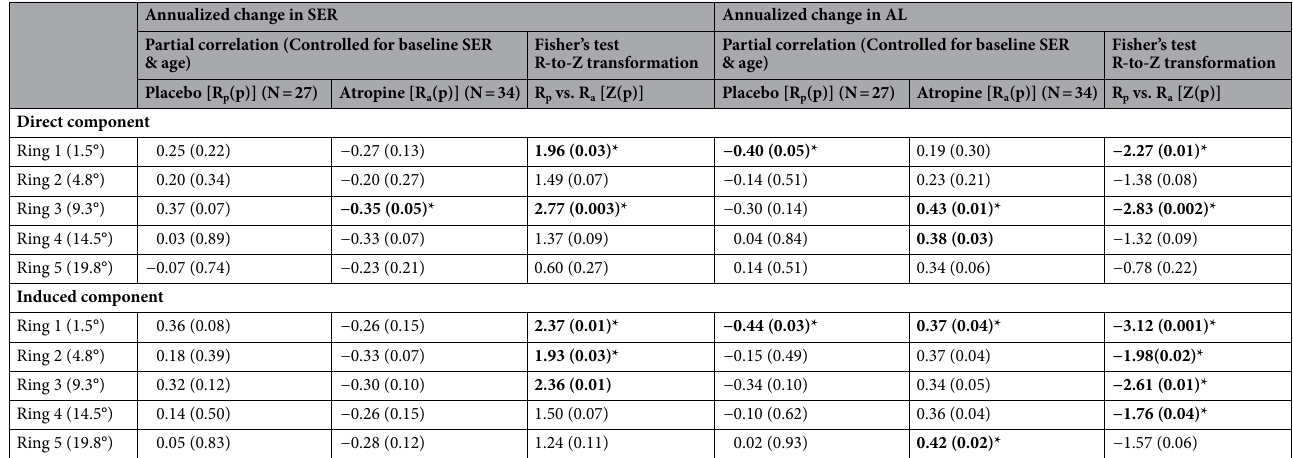
Annualized change in SER